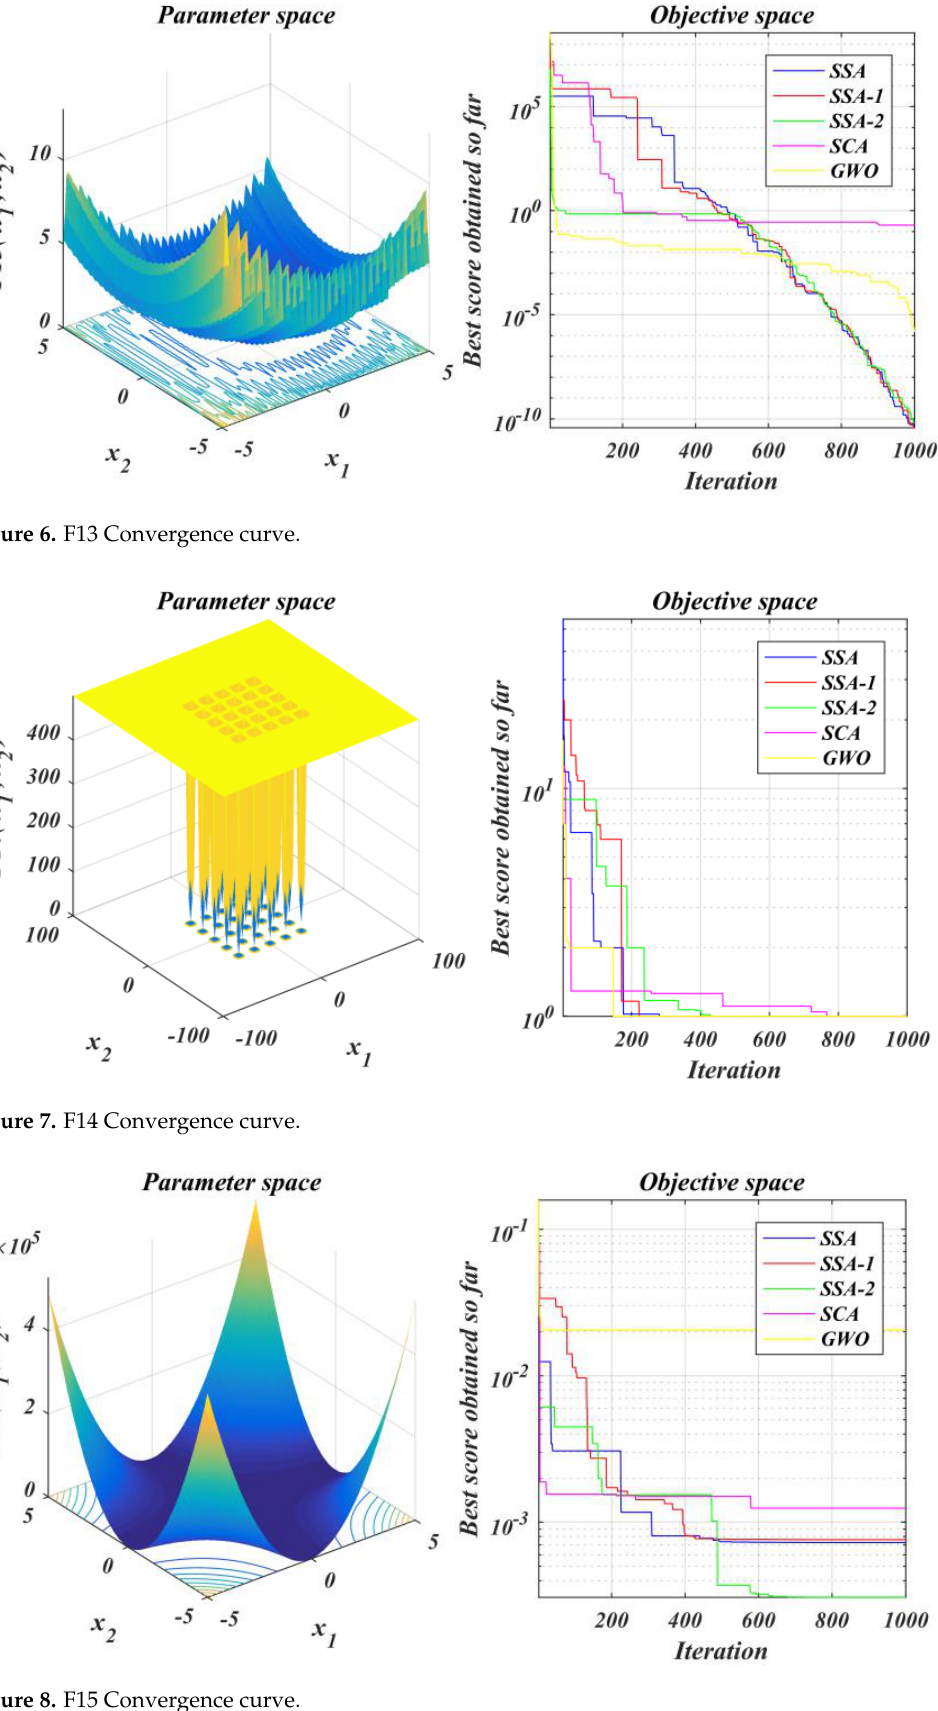
Figure 8. F15 Convergence curve.